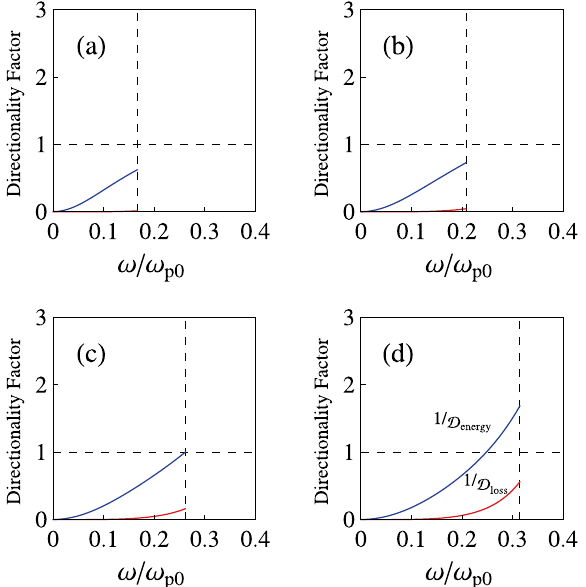
Figure 4. Variation of 1 / D energy (blue curves), and 1 / D loss (red curves) as a function of the dimensionless frequency ω/ω p0 for a multilayer HMM as type-II HHM (for example gold-SiO 2 multilayer HMM in the visible and near-IR range 28 ). Here, the permittivity ε m of a gold layer is characterized by the Drude model and we use ε d ε SiO 3.9 . For the other parameters we consider ε 2 = = shows ω = (cid:31)